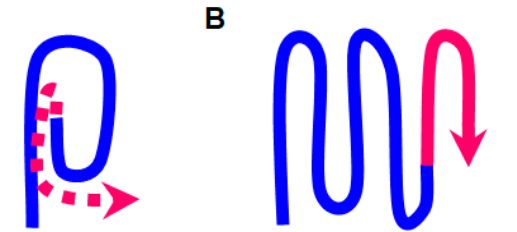
Figure 6. Two variants of the amyloidogenic protein terminus folding in prions and amyloids. ( A ) In the proposed buried location of the terminus (blue) it may be difficult to accommodate additional sequences (red), while no such problem should occur in the “serpentine” fold ( B ).